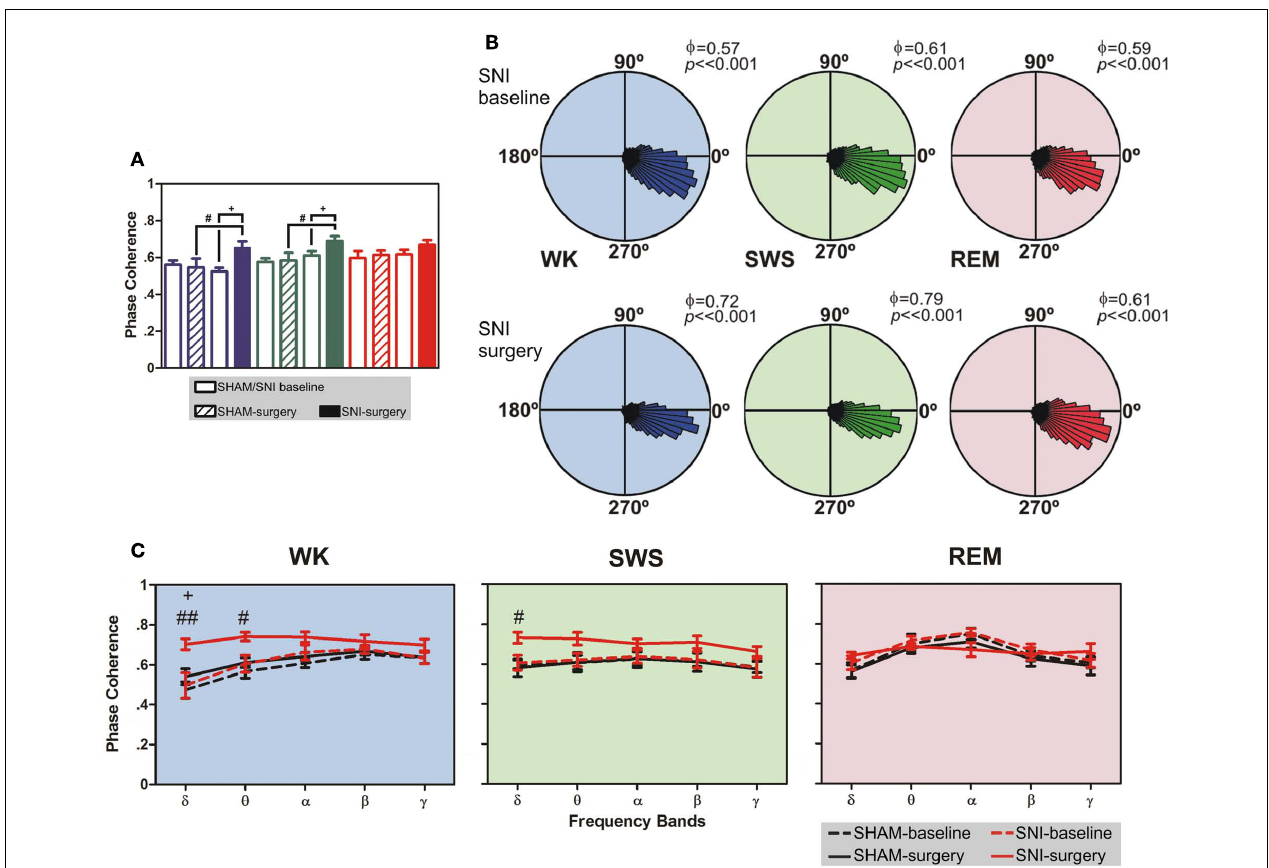
test, P < 0.01) indicating a high degree of thalamocortical phase synchronization. (C) Average phase–coherence across frequency bands analyzed during the baseline and respective SHAM or SNI lesion (surgery). Frequency bands: delta ( δ , 1–4Hz), theta ( θ , 4–9Hz), alpha ( α , 9–15Hz), beta ( β , 15–30Hz), and slow-gamma ( γ , 30–50Hz). Comparison of SNI-surgery in respect to SNI-baseline (plus symbols), and to SHAM-surgery (cardinal symbols).Values are expressed as mean ± SEM. + /# P < 0.0125, ++ /## P < 0.0025, +++ /### P < 0.0002 (Bonferroni test with corrected P